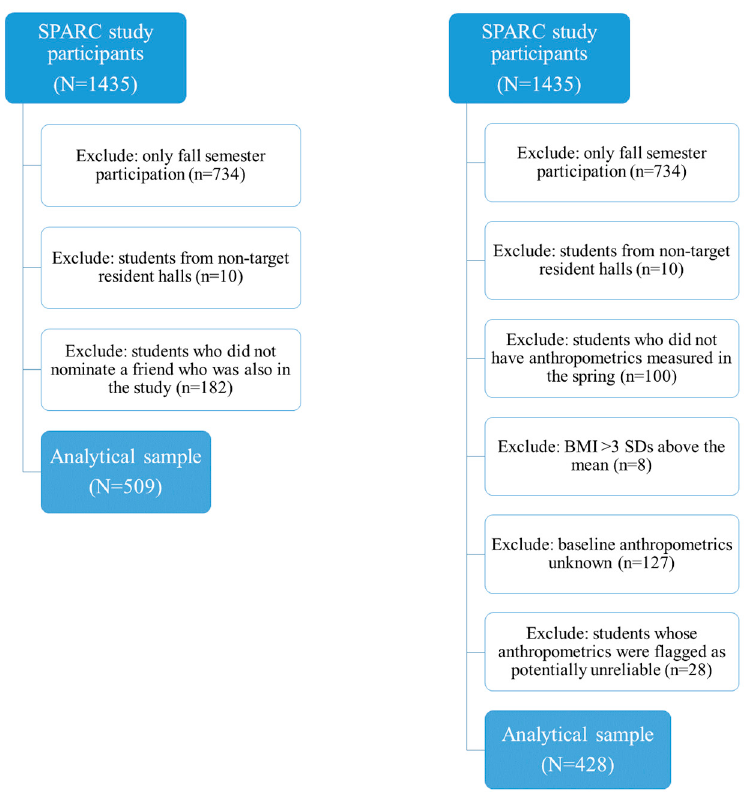
Figure 1. Flowchart of the study population and sample size for the analysis of friend similarities and behaviors ( left ), and behavioral associations with anthropometrics ( right ).